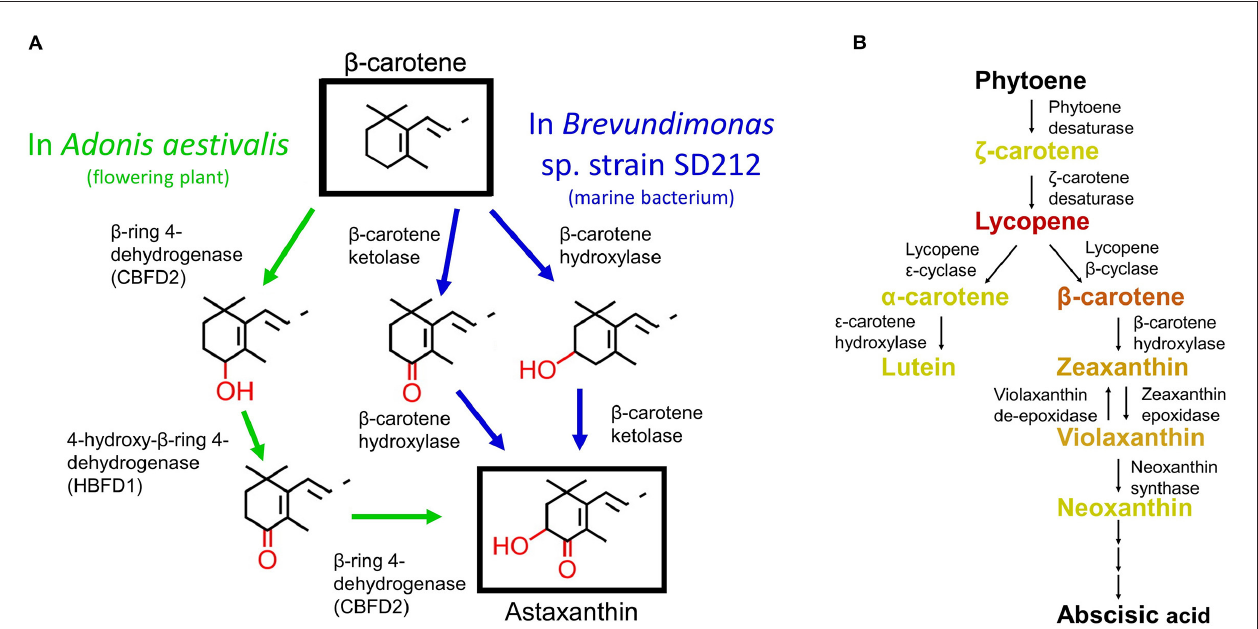
FIGURE 1 | (A) Two routes of astaxanthin biosynthesis from β -carotene in nature. The pathway with green arrows details the three-step reaction involving the two enzymes in Adonis aestivalis . The pathway with blue arrows details the two-step reaction involving two enzymes from Brevundimonas sp. SD 212. The two separate blue pathways indicate that the two steps can occur in either order. (B) Simplified carotenoid pathway present in most higher plants. The names of the compounds are color coded to symbolize the actual color of the molecules. Names written in black are colorless in nature. Abscisic acid is not a full-length carotenoid, but rather an important apocarotenoid derivative. (A) modified from Cunningham and Gantt (2011) and (B) modified from Wei et al.